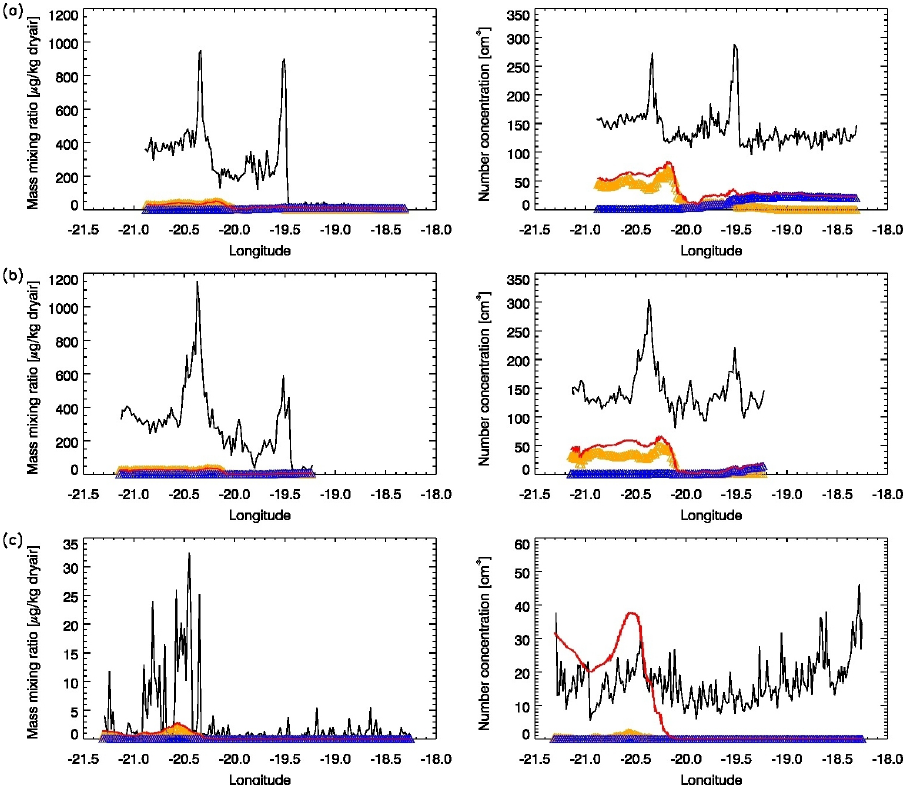
Fig. 15. As in Fig. 12 but for model results from the run